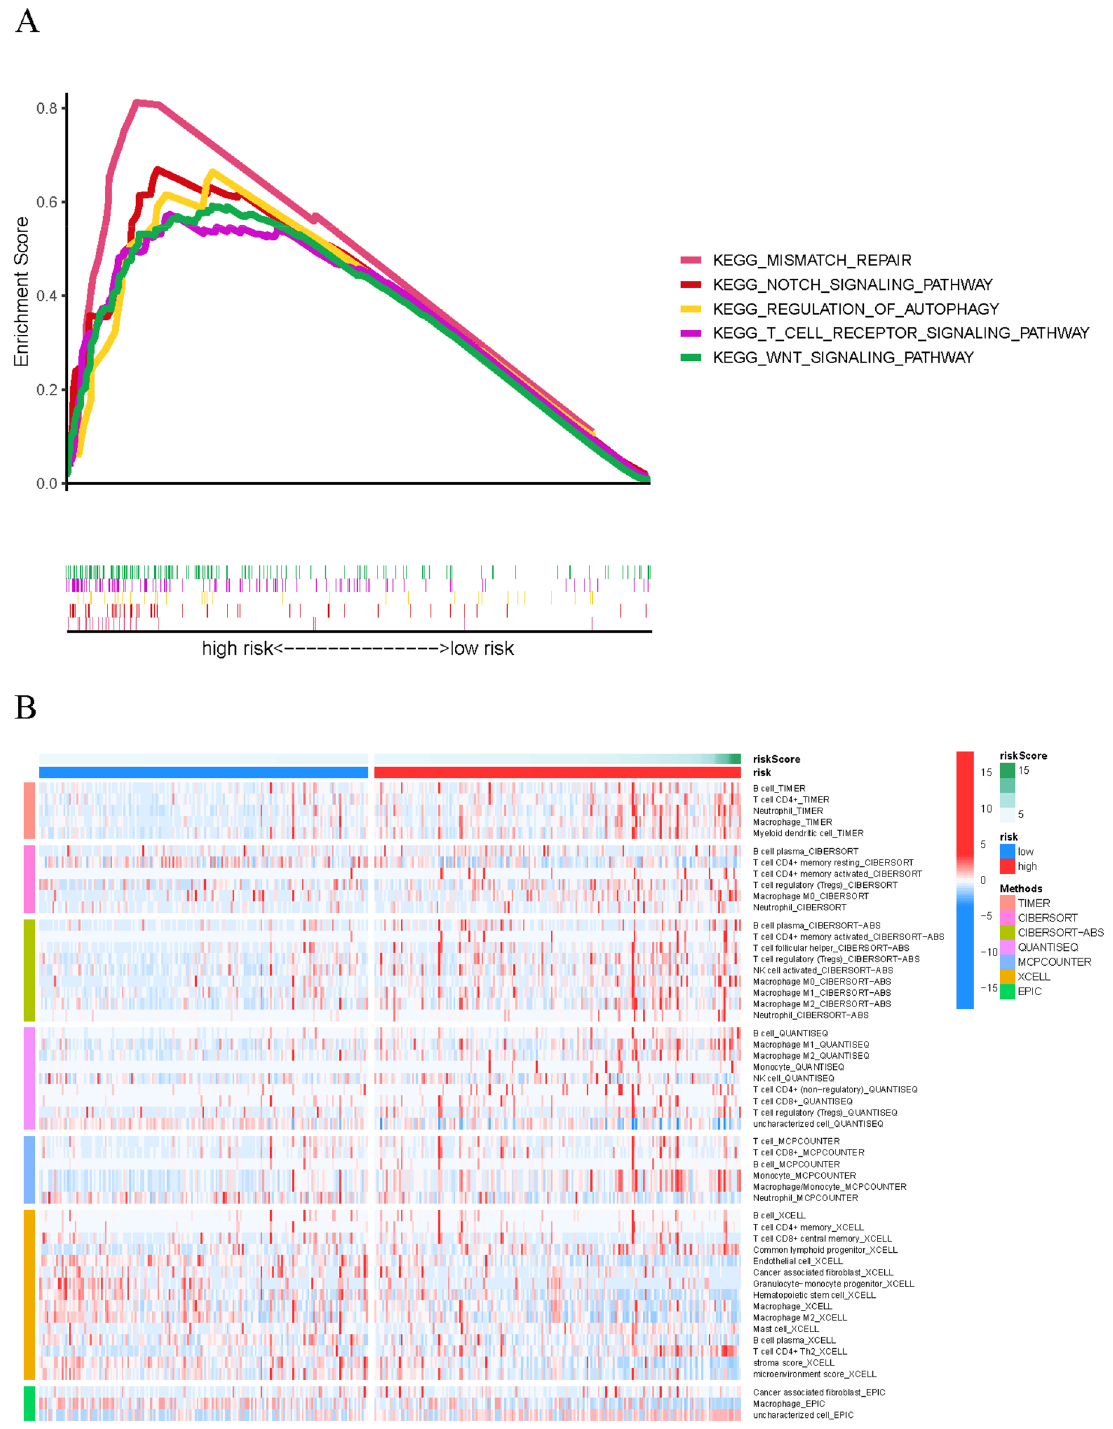
Figure 8. ( A ) Gene enrichment analysis for ferroptosis-related lncRNAs based on TCGA entire set. ( B ) Heatmap for immune infiltration based on TIMER, CIBERSORT, quanTIseq, MCP-counter, xCELL, and EPIC algorithms among high- and low-risk